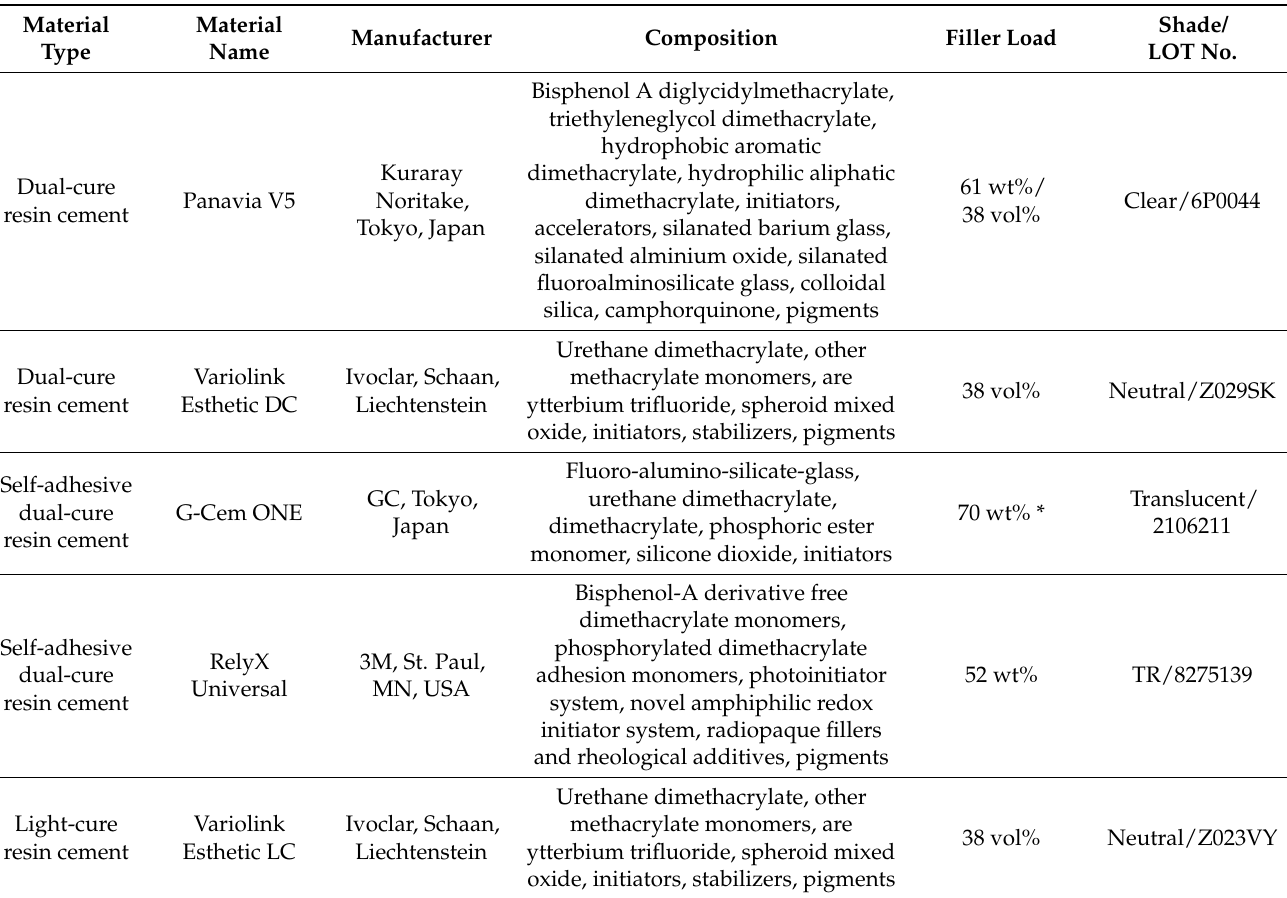
Table 1. Composition of the investigated resin cements as provided by their respective